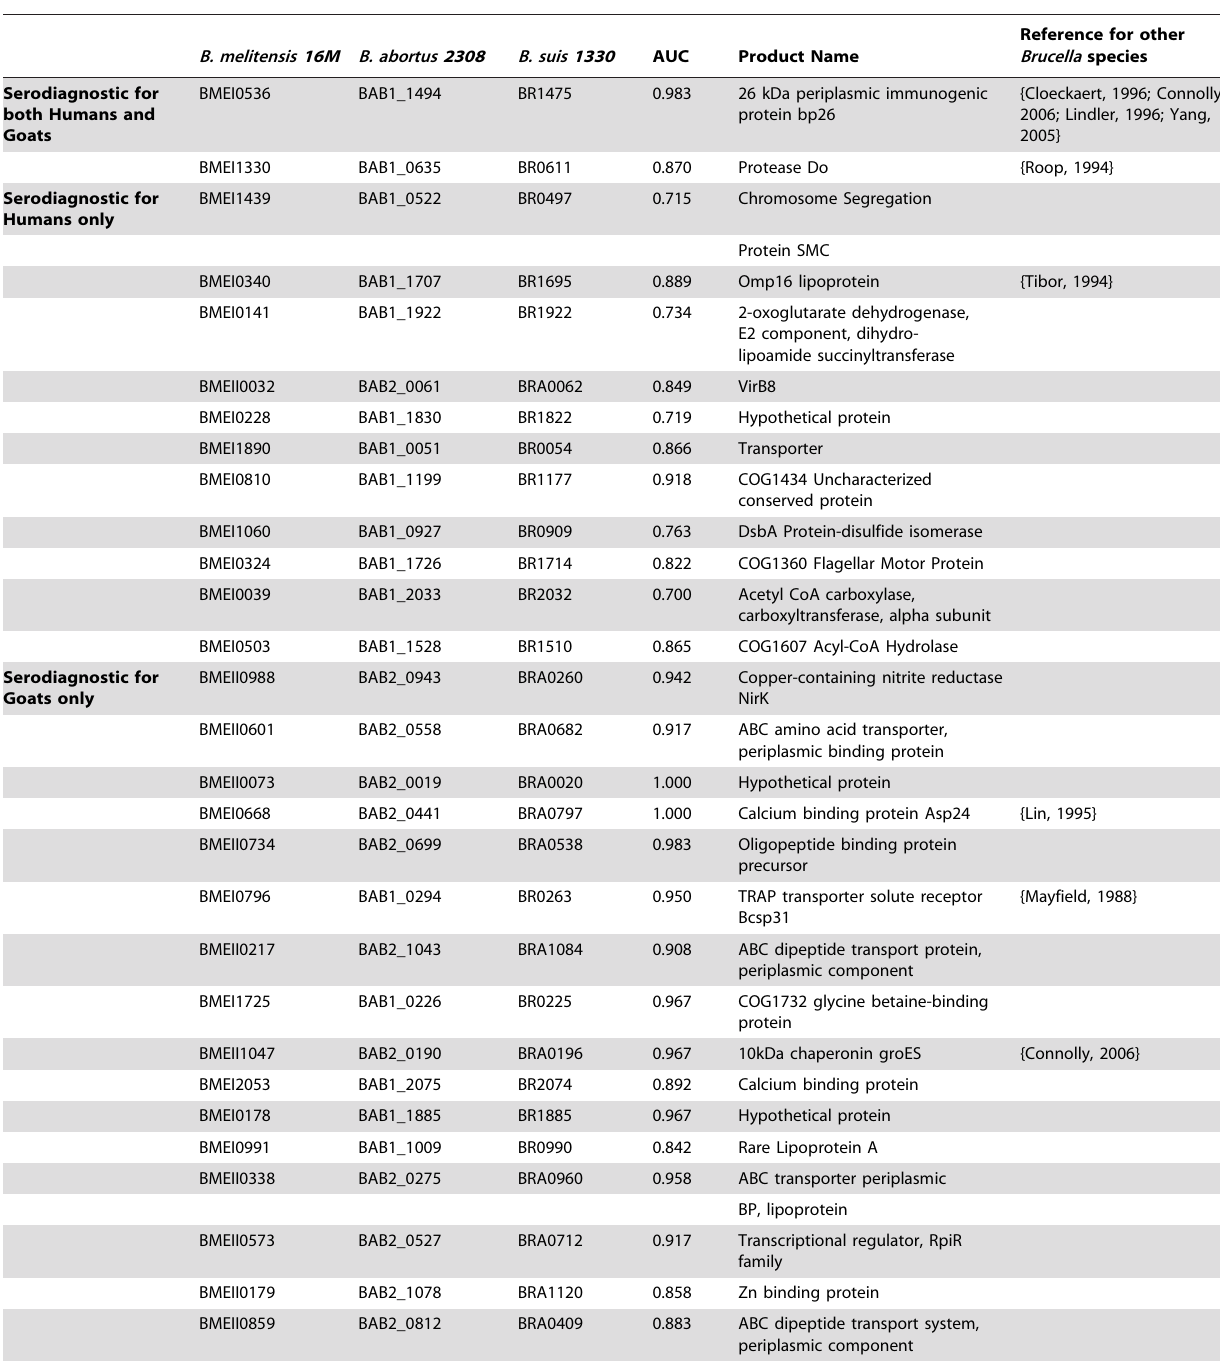
Table 1. Common and specific Brucella melitensis antigens for humans and